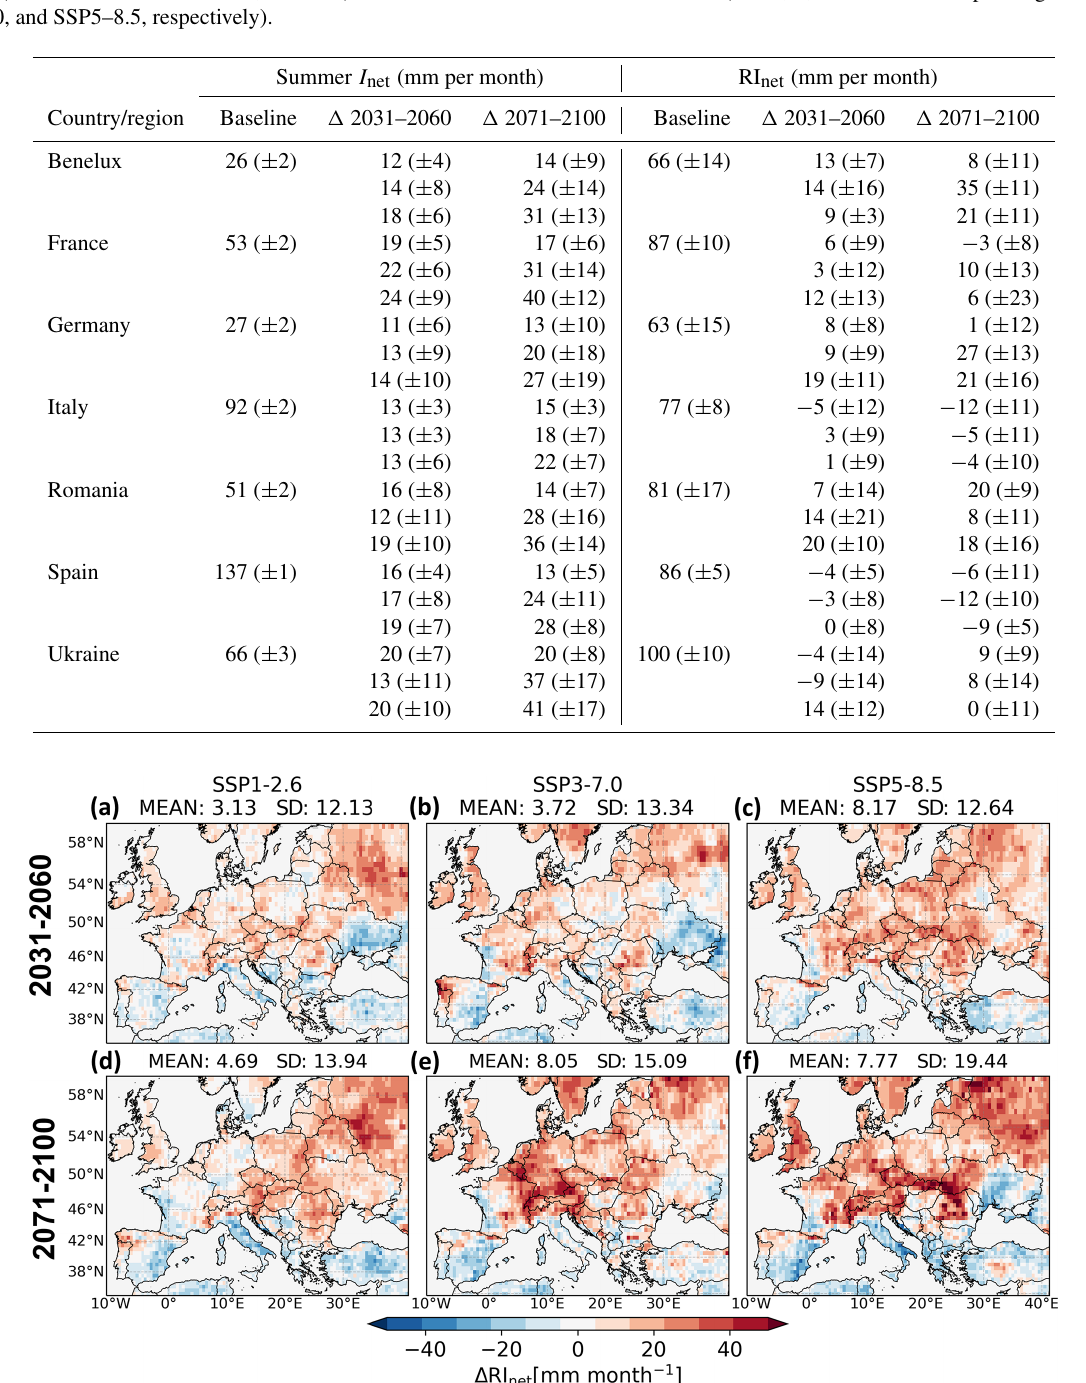
Table 4. Median across GCMs ( ± standard deviation of GCMs) of baseline summer I net , (cid:49)I net , baseline RI net , and (cid:49) RI net (mm per month), spatially averaged over the country, for six European countries and the Benelux region. The changes (cid:49) are presented for the two future horizons (2031–2060 and 2071–2100, columns) and for the different emission scenarios (line 1, 2, 3 of a cell corresponding to SSP1–2.6, SSP3–7.0, and SSP5–8.5, respectively).